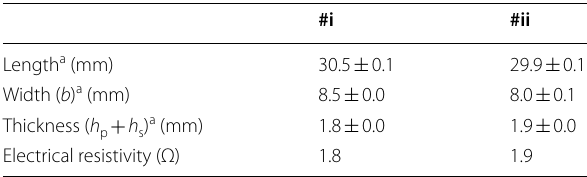
Table 3 Size of prototype force